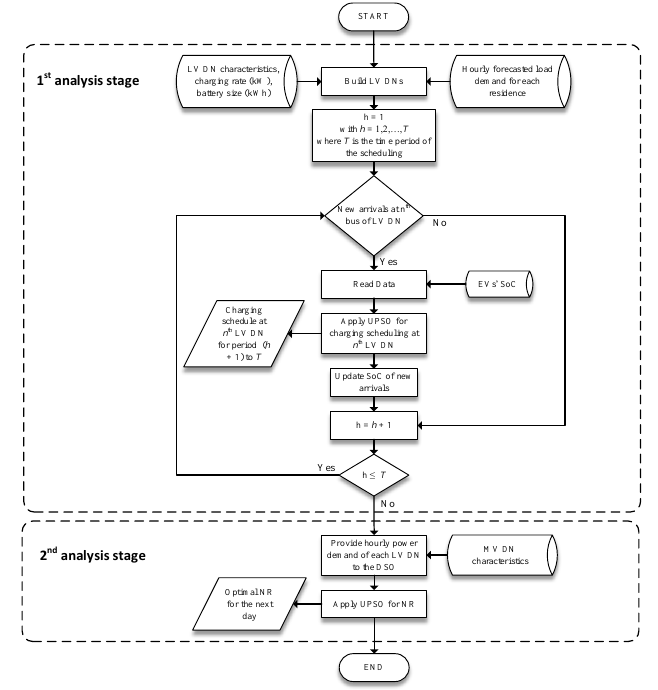
Figure 2. Flowchart of the proposed methodology.